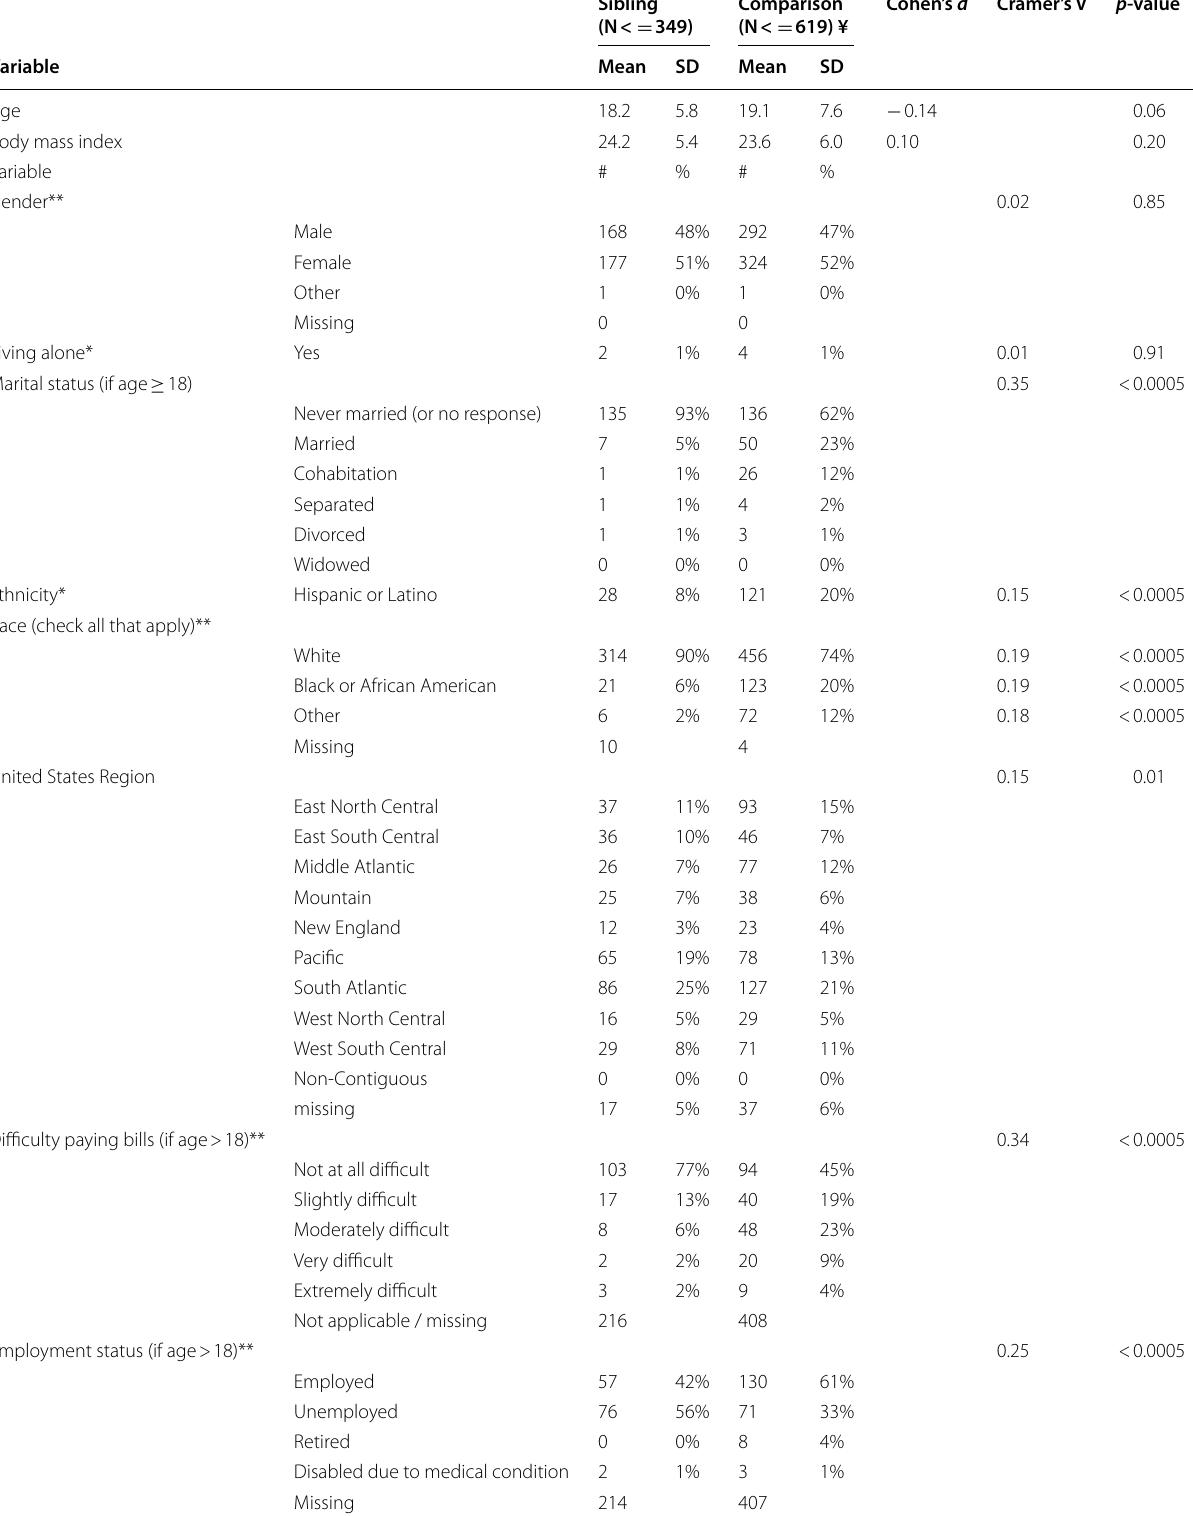
Table 1 Sample Demographic Characteristics (N